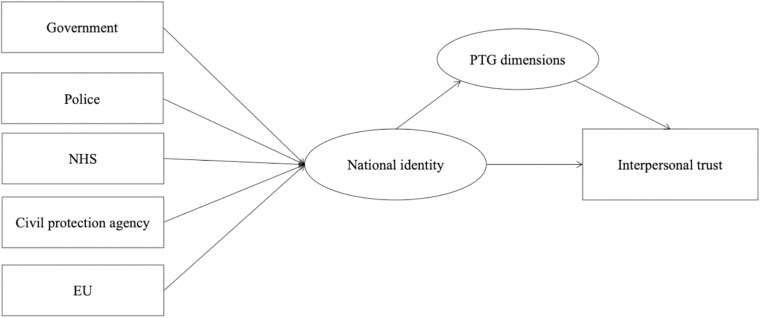
Conceptual model.